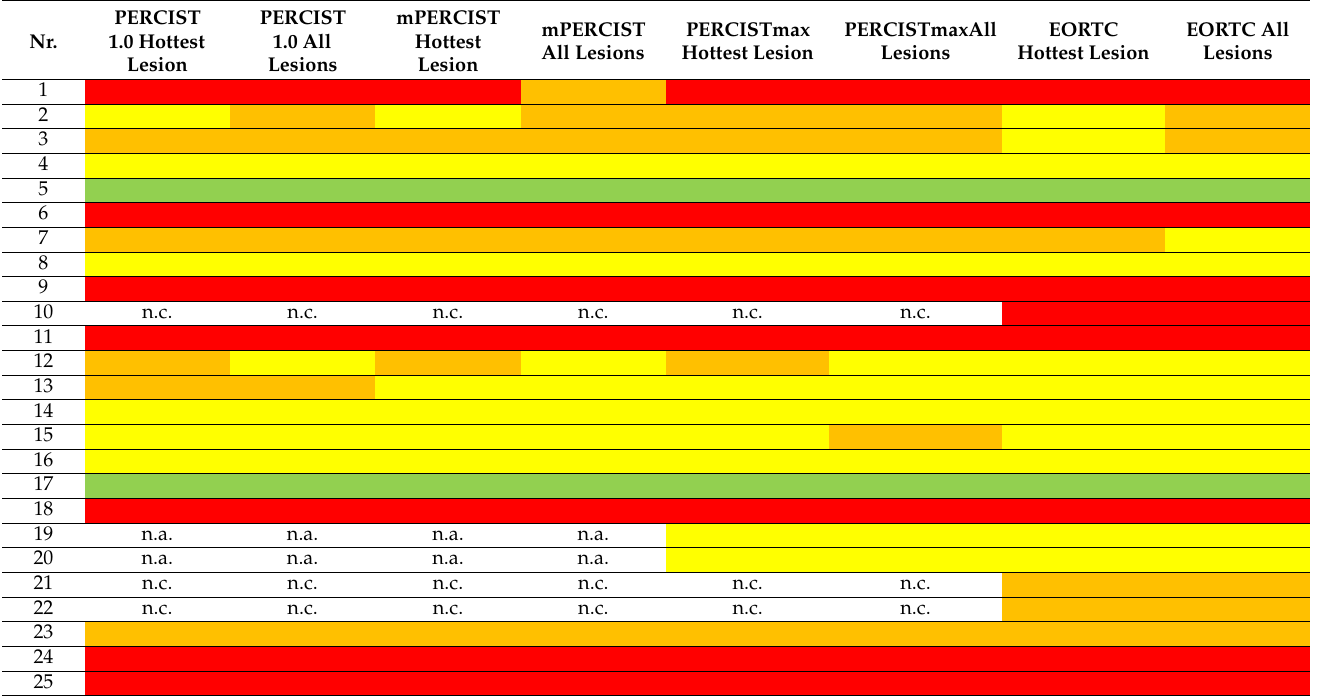
Table 3. Response classification by mPERCIST, PERCIST 1.0, PERCISTmax and EORTC—Comparison of analysis of the single hottest lesion (hottest lesion) vs. lesions in all compartments (all lesions) EORTC = European Organization for Research and Treatment of Cancer; PERCIST 1.0 = PET Response Criteria in solid Tumors; mPERCIST = modified PERCIST using SUVpeak; PERCISTmax = modified PERCIST using SUVmax; CMR = complete metabolic response (green); PMR = partial metabolic response (yellow); SMD = stable metabolic disease (orange); PMD = progressive metabolic disease (red); n.a. = SUVpeak/SULpeak not available; n.c. = PET studies not